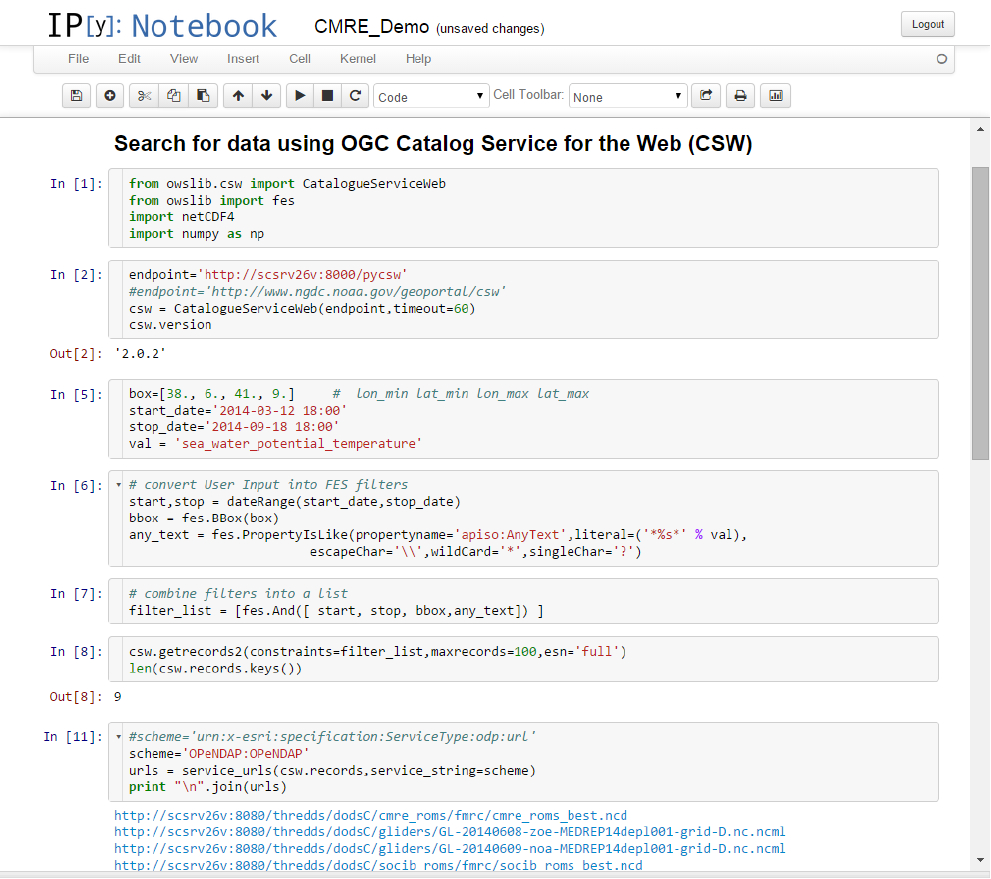
Figure 5. A snippet from an IPython Notebook demo, demonstrating a geospatial, temporal and free-text search for data using the owslib package to construct CSW queries and parse the results. Nine records are found, and the OPeNDAP data endpoints are then selected, from which data can be extracted in a common way, since CF conventions are used. © North Atlantic Treaty Organization, all rights reserved. Provided by